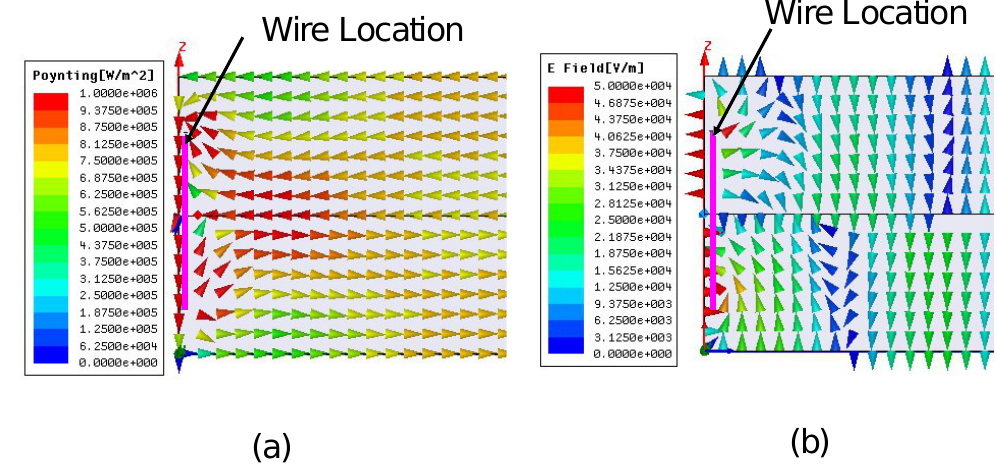
Figure 4. ( a ) Poynting vector ((power flow) plot and ( b ) electric field pattern on the magnetic wall (y-z plane) of the parallel plate waveguide unit cell at 31.96 GHz for the case in which the wire-length to waveguide-height ratio t =